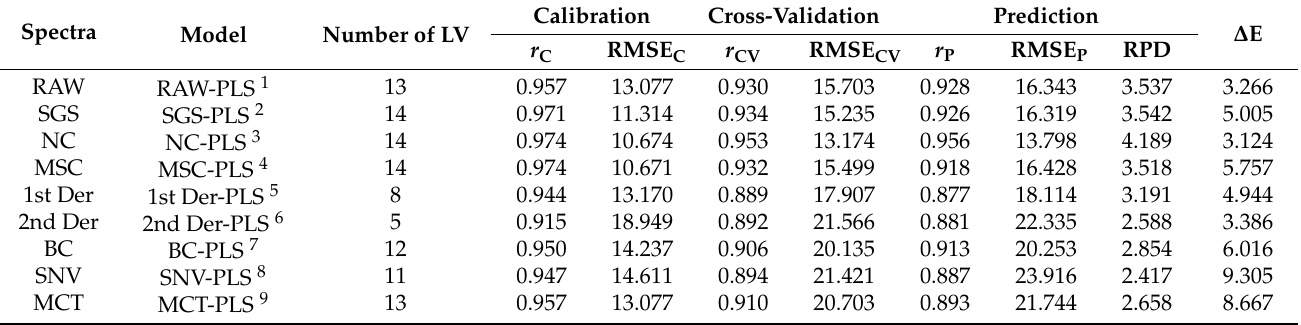
Table 2. Prediction of vitamin C (mg/100 g) in citrus peel by PLS model using full 375